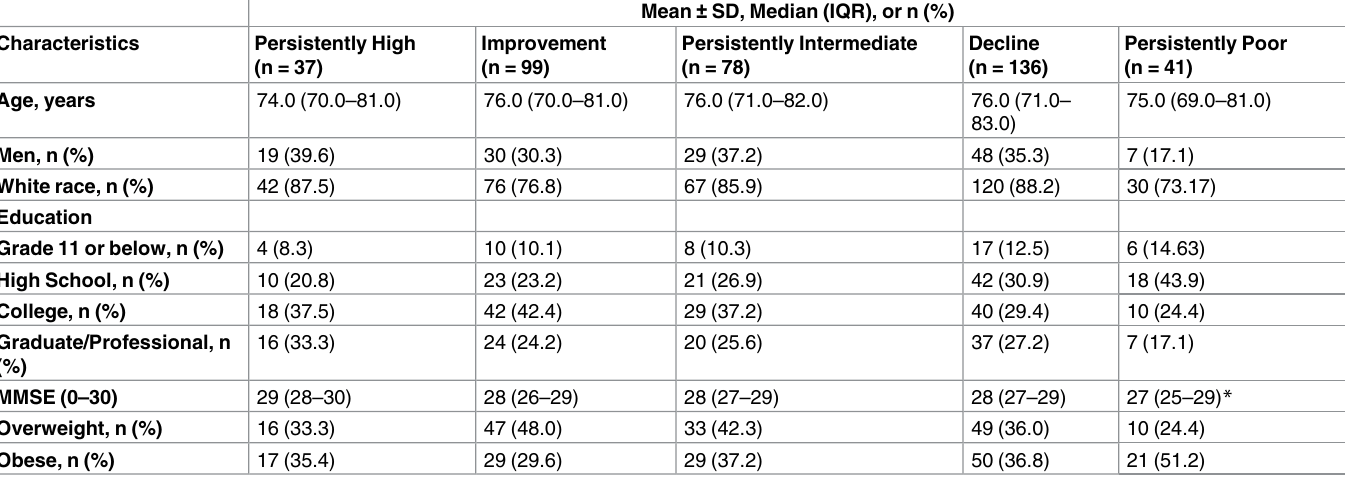
Mean ± SD, Median (IQR), or n (%)